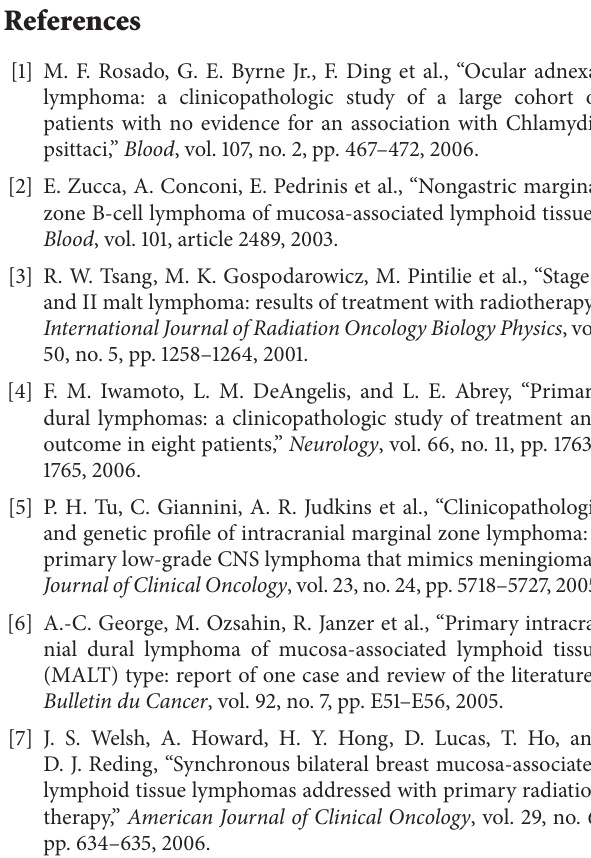
Table 1: Characteristics of the English-language reported cases of supraglottic laryngeal lymphomas from 1997 to 2014. Study Age at presentation Gender Zhao et al., 2012 [15] Hoarseness Markou et al., 2010